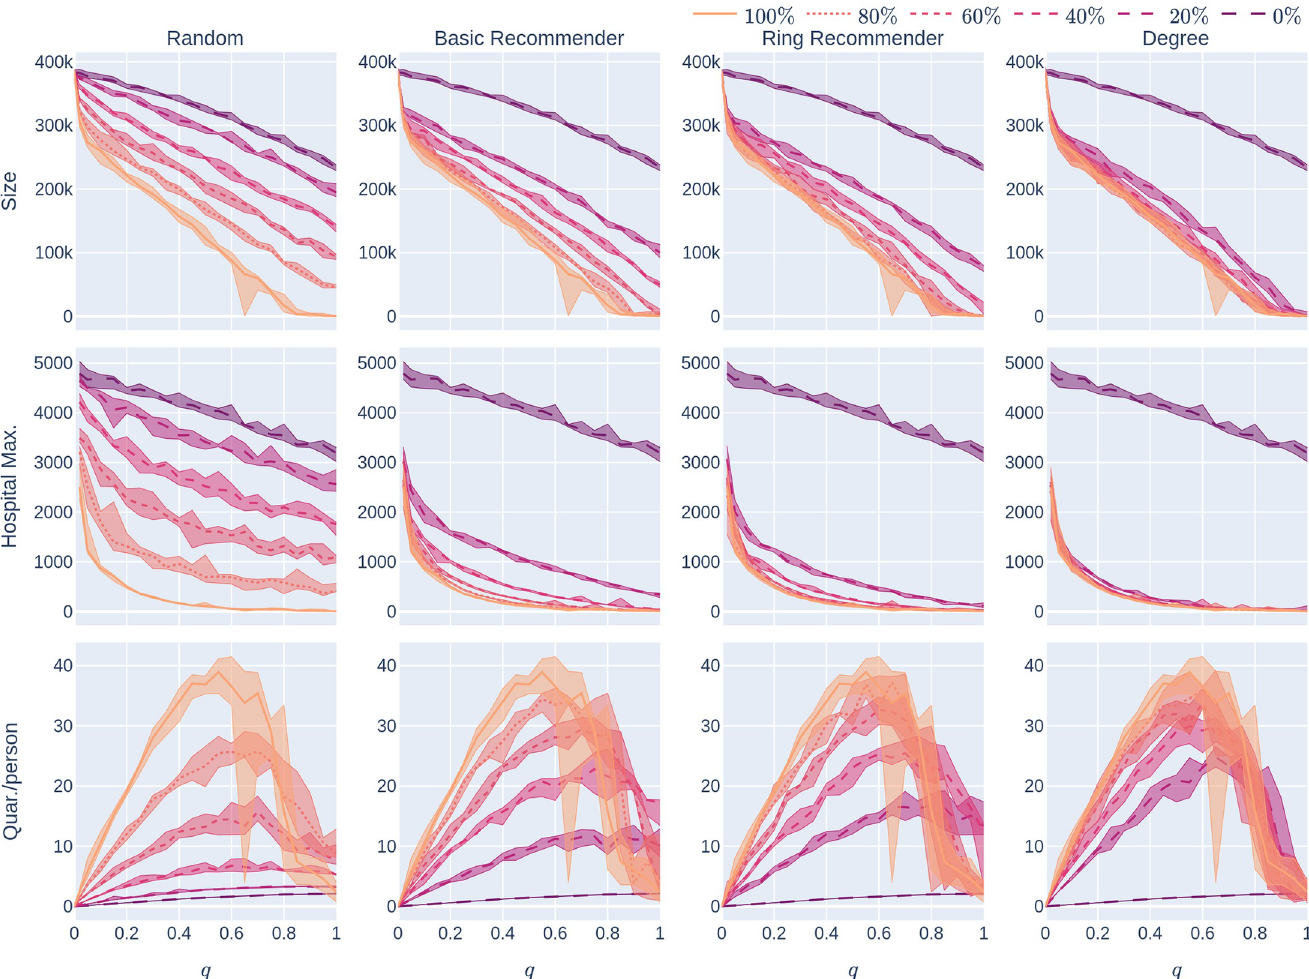
Fig 14. Experiment 2 on a less geometric network with many super-spreaders: Influence of the quarantine strictness q for various uptake percentages p % and the four uptake scenarios: The KPIs are plotted against q , the quarantine strictness. We work here with a fixed underlying network, a 500,000 node GIRG with τ = 2.3 and α = 1.3. In this case, the parameter α does not have a significant effect since long-range edges are present because of the super-spreaders: the figures are very similar to those in Fig 15. Each column represents a given uptake scenario (random, basic-recommender and ring-recommender, and degree-targetted). The x -axis shows the quarantine strictness q varying from 0 to 1 at step size 0.05. Simulations are done for the 21 values of q corresponding to these steps. There is an additional simulation point at 0.02 (in order to avoid division by 0 in the computation for HMax and still have a point close to 0). The y -axis shows the corresponding value of the KPI. The curves on each figure correspond to the different uptake percentages, as labelled. For each parameter value, the plotted result is the median over 5 runs. The shaded region around the plot covers the results of all 5 simulations. The epidemic is started by infecting 100 individuals, chosen uniformly at random. Simulation is halted when there are no more exposed or infected vertices. The infection rate is β =